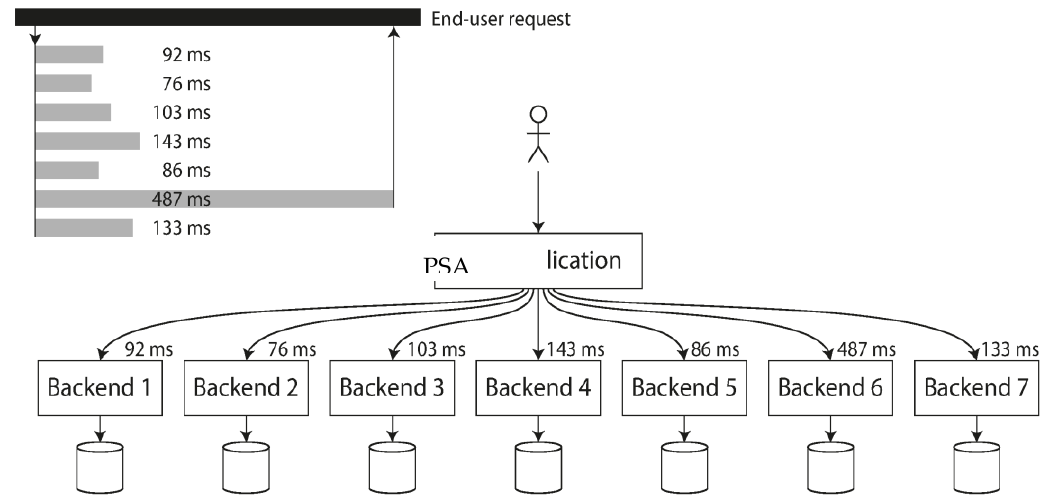
Figure 11. PSA backend calls in end-user request.